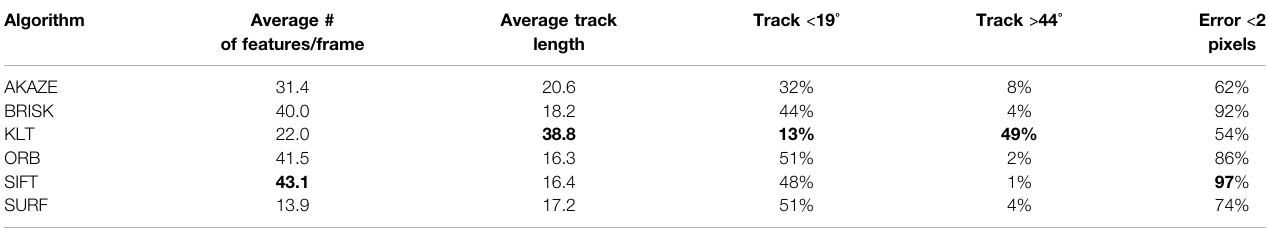
TABLE 1| Comparison ofpersistence and accuracy ofstate-of-the-art featuretrackers on images ofaprincipal-axis rotating small body at a body-image span of150 pixels and a delta rotation of 1.25 ° per frame.